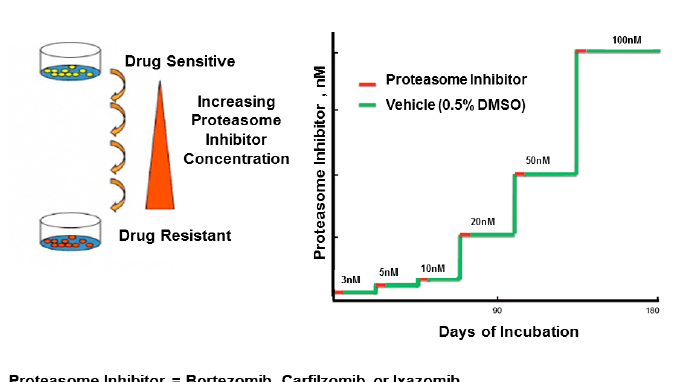
Figure 1. Scheme to generate myeloma cell lines resistant to proteasome inhibitors. Drug ‐ naïve parental RPMI8226 cells were exposed to either vehicle (dimethyl sulfoxide (DMSO) 0.05%) or bortezomib, carfilzomib, or ixazomib at indicated concentrations. Cells were exposed to the vehicle or drugs for three days, pelleted, washed, grown in fresh media for three weeks, and then exposed to the vehicle or drug at the higher concentration. Genes 2016 , 7 , 84